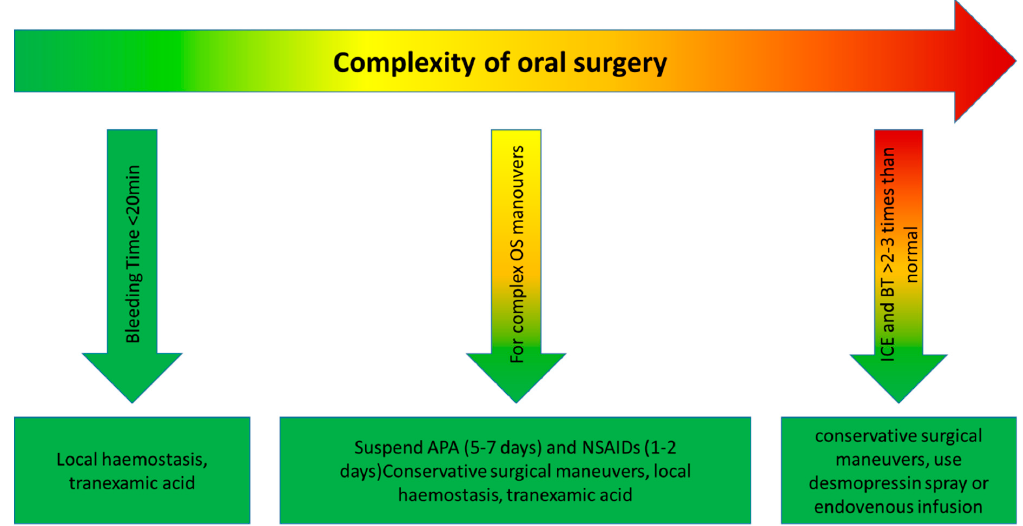
Figure 5. Protocol in patients on antiplatelet therapy related to the complexity of oral surgery (BT: bleeding time; ICE: in case of emergency; OS: oral surgery; APA: anti-platelet; NSAIDs: non-steroidal anti-inflammatory drugs).